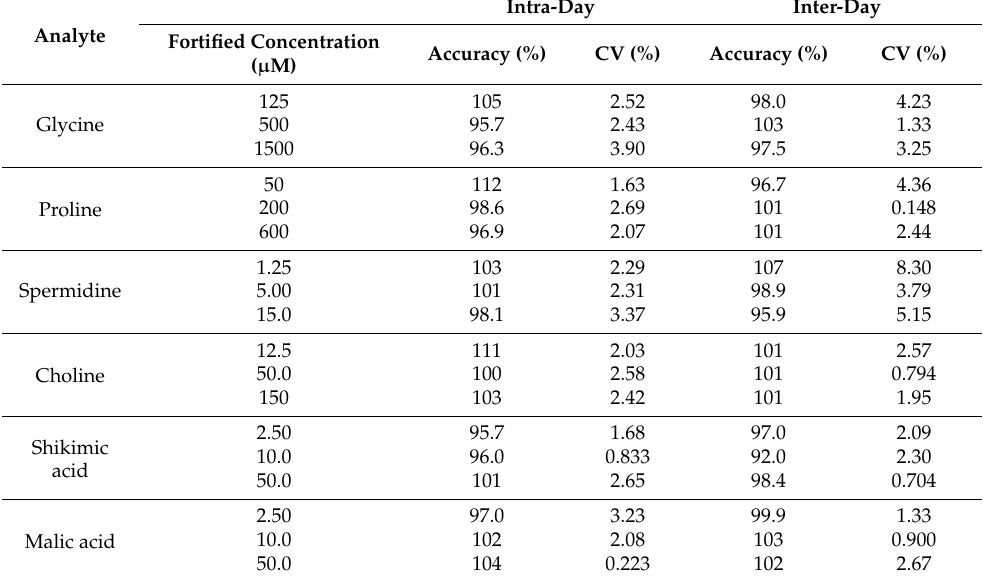
Table 3. Intra- and Inter-day Accuracy and Precision of Representative Analytes.